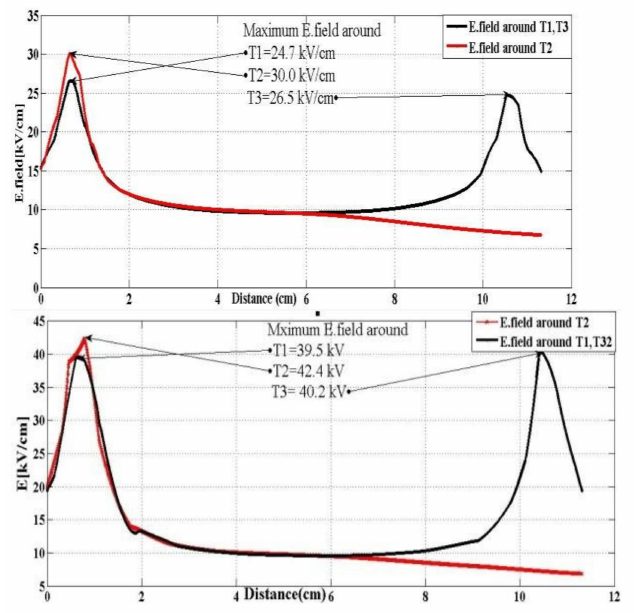
Figure 9. Electric field plot on an L-shape geometrical structure with and without upward leaders’ inception.